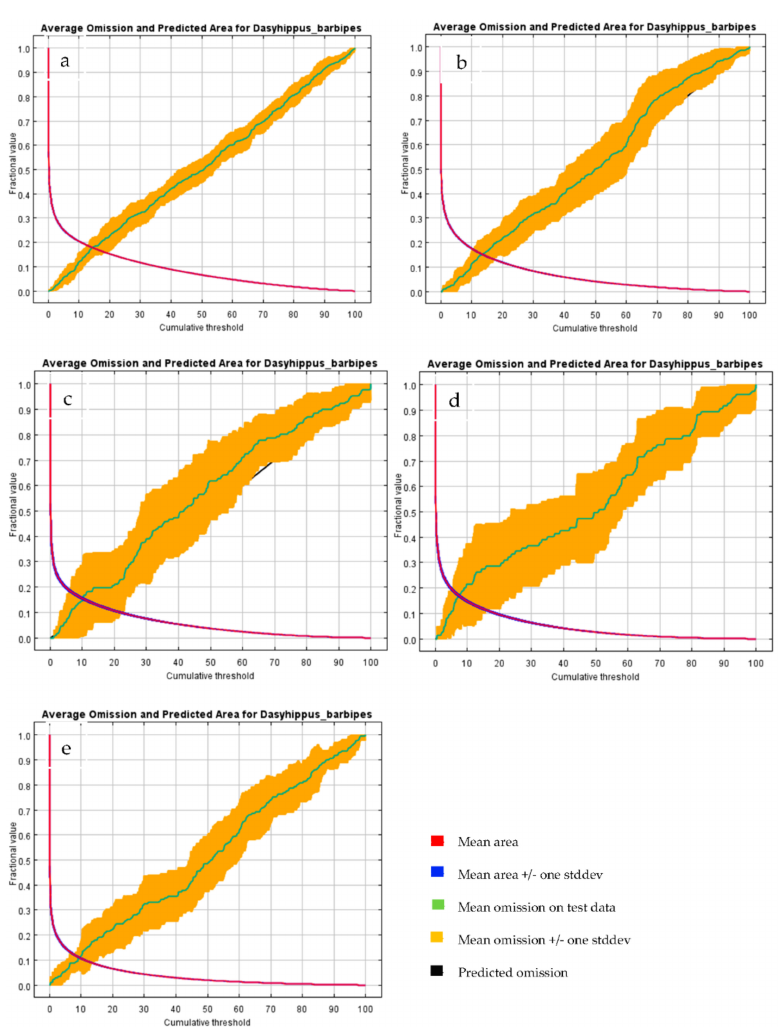
Figure 5. The relationships between the omission rate, occurrence probability and cumulative threshold at different density levels: ( a ) all survey points; ( b ) the low-density survey points; ( c ) the medium–low-density survey points; ( d ) the medium–high-density survey points; ( e ) the high-density survey